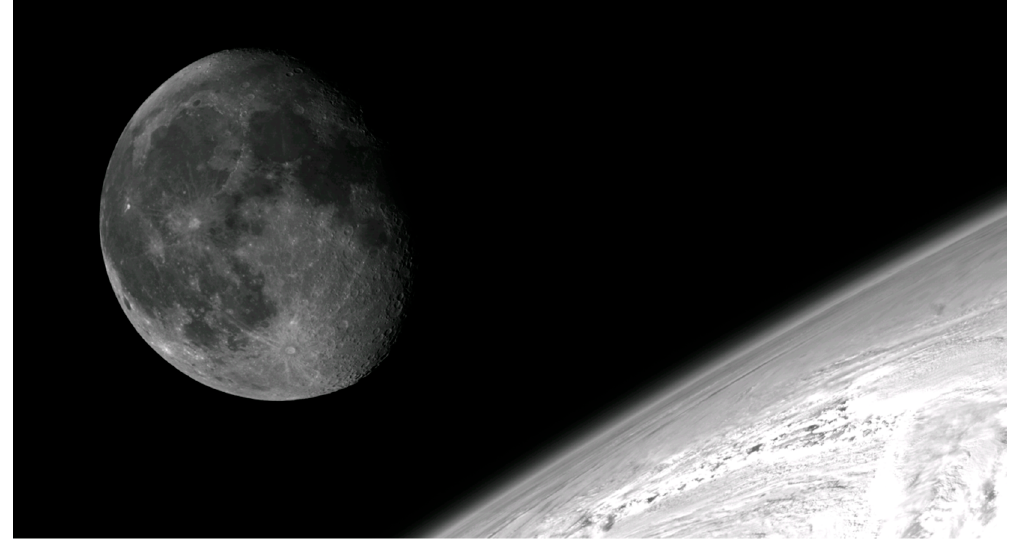
Figure 6. An ABI image of the Moon and portion of the Earth observed by GOES-16 on 11 January 2017 in band 2 (0.64 μ m).